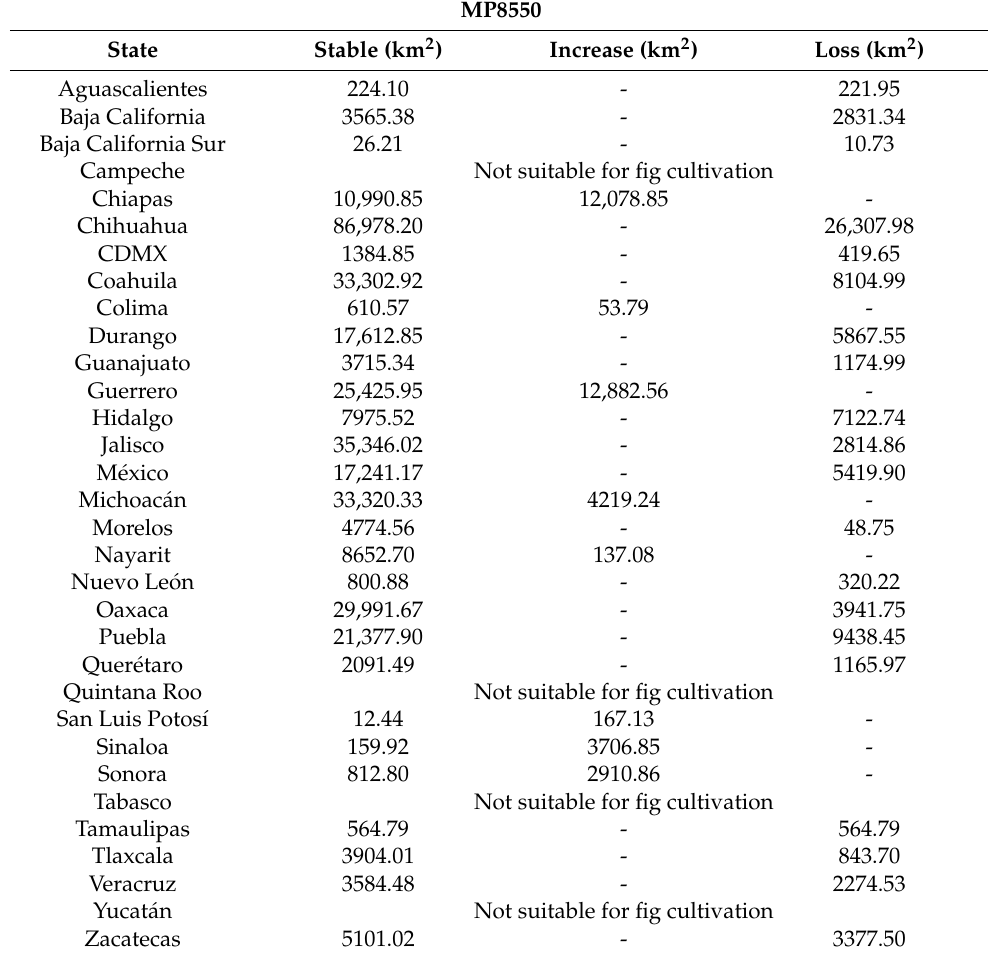
Table A4. Area estimated of fig crop for the year 2050 for the MPI-ESM-LR Model with RCP 8.5.